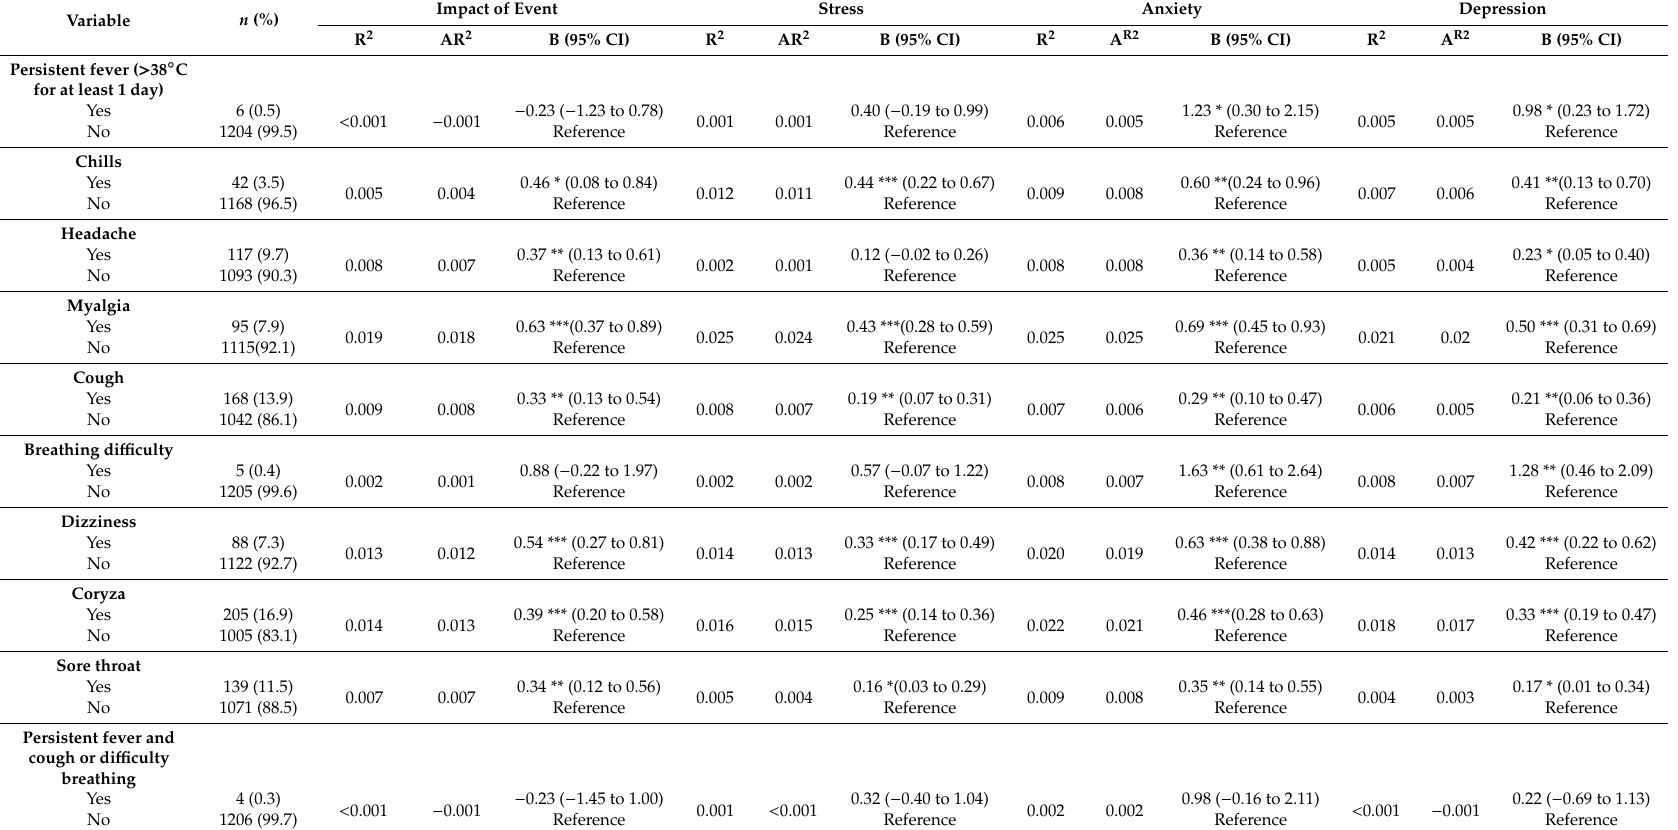
Table 2. Association between physical health status in the past 14 days and the psychological impact of the 2019 coronavirus disease (COVID-19) outbreak as well as adverse mental health status during the epidemic ( n =